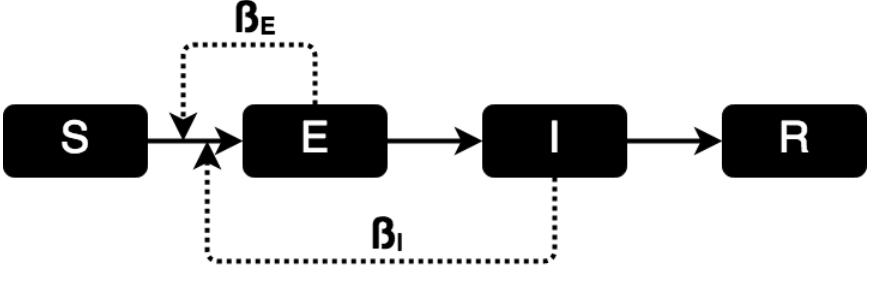
Figure 1. Scheme of the SIR